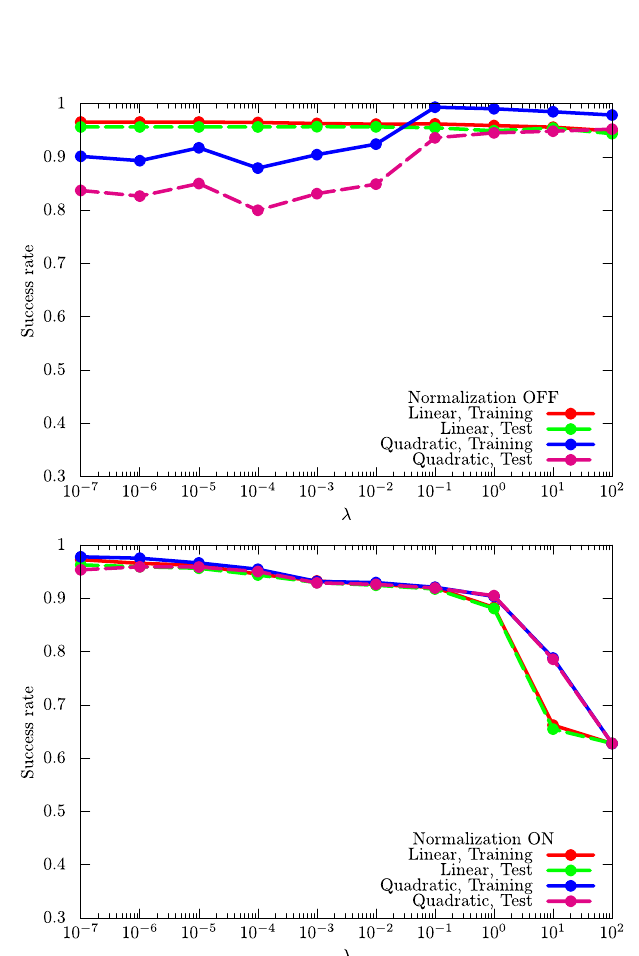
Figure 5. Performance dependence of the kernel method on (cid:31) , which is the coefficient of the regularization term for the cancer dataset (0 or 1). For φ( · ) , we use linear and quadratic functions (upper panel) with and (lower panel) without